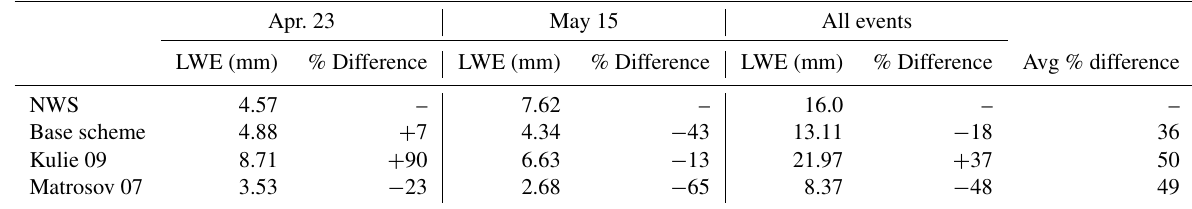
Table 5. Retrieved snowfall amounts as derived from two different Z e – S relationships for the 23 April, 15 May, and all snow events seen at Barrow. These results are contrasted with those found using our base optimal-estimation scheme and NWS observations. Difference values are defined as in Table 4. Apr. 23 May